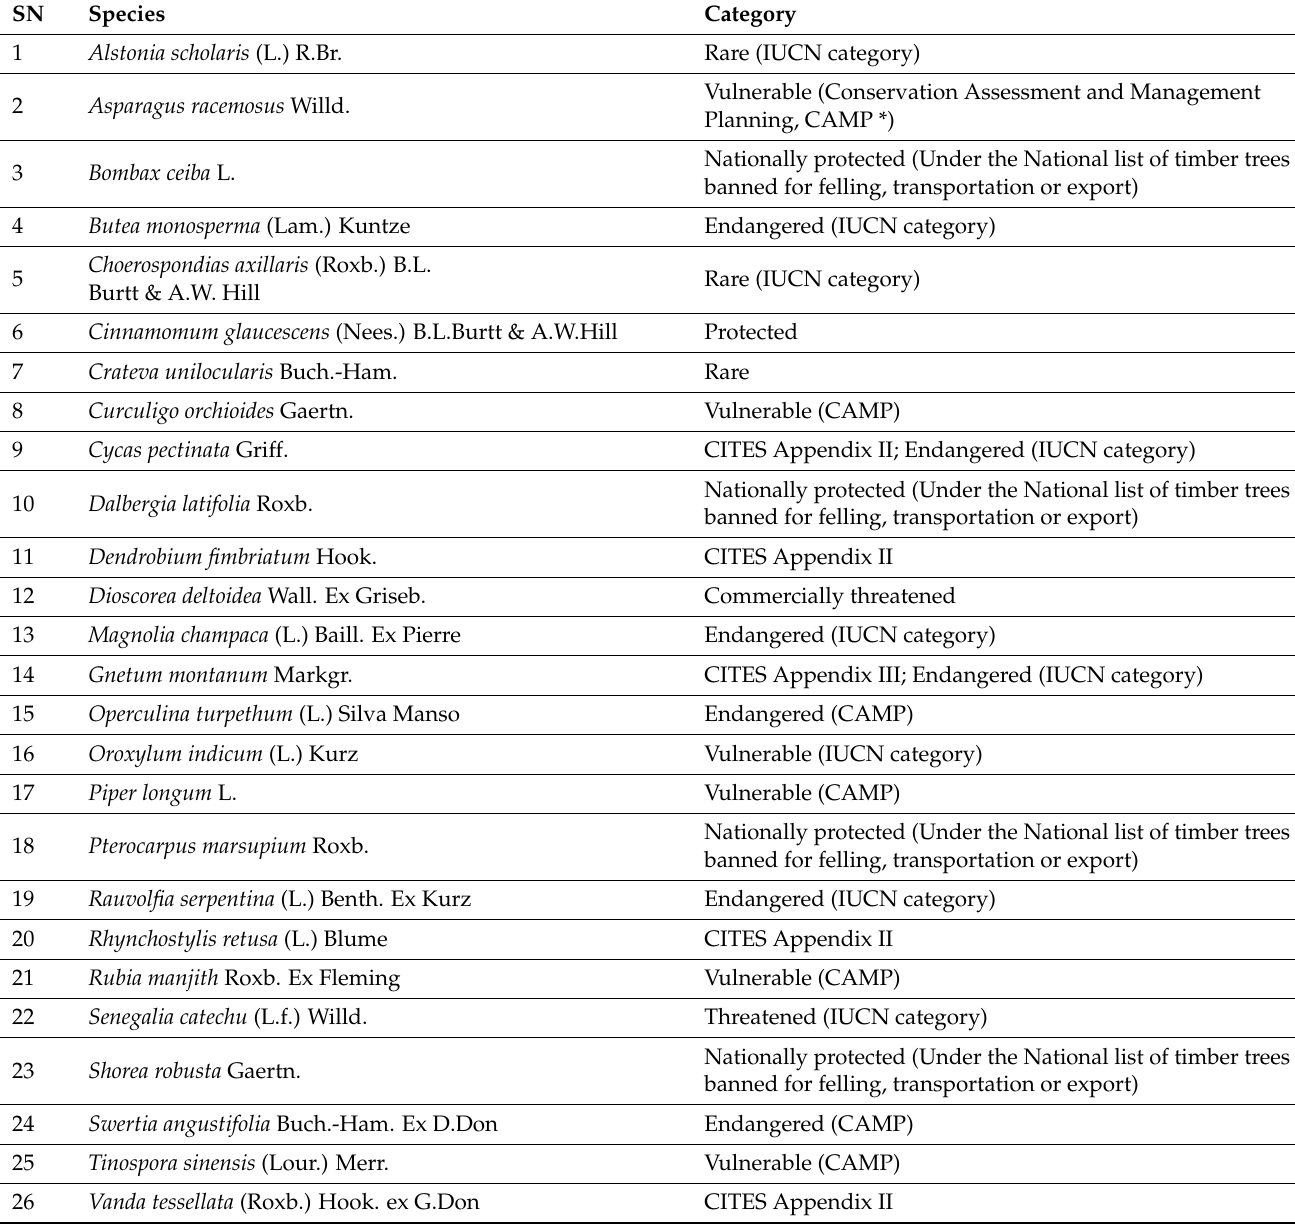
Table 4. Plant species with different conservation status in